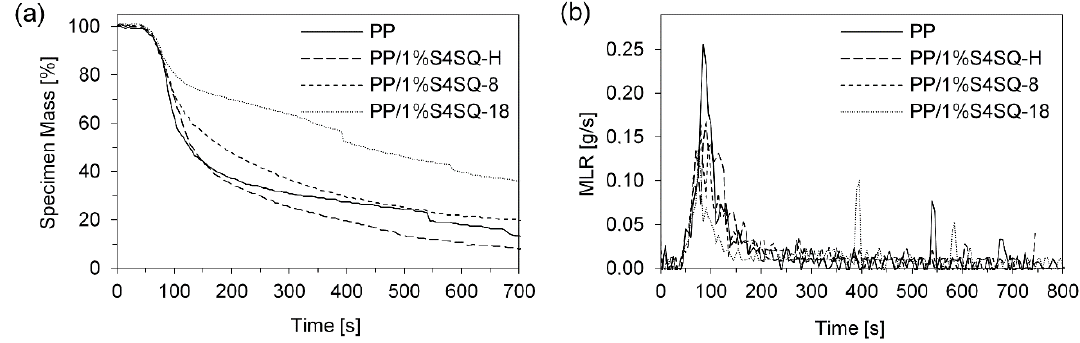
Figure 8. Mass curves during combustion for neat PP and PP/S4SQ composites: ( a ) sample mass (normalized on initial weight) and ( b ) mass loss rate (MLR).